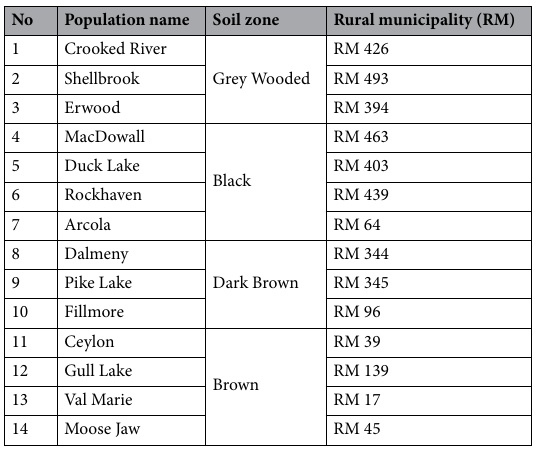
Table 6. Soil zone and rural municipality of 14 long-term grazing sites in Saskatchewan Canada used for alfalfa plant